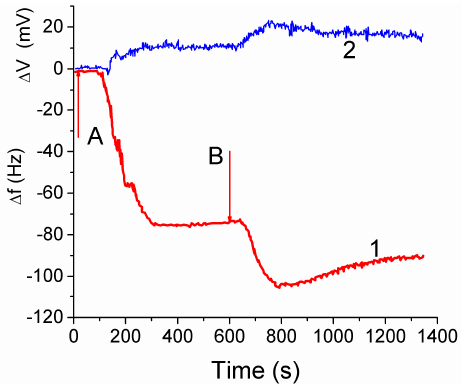
of 0.1 mL aliquot of 3T3 fibroblast suspension (2.0 × 10 6 cell mL − 1 ) upon an unsupported section of CG